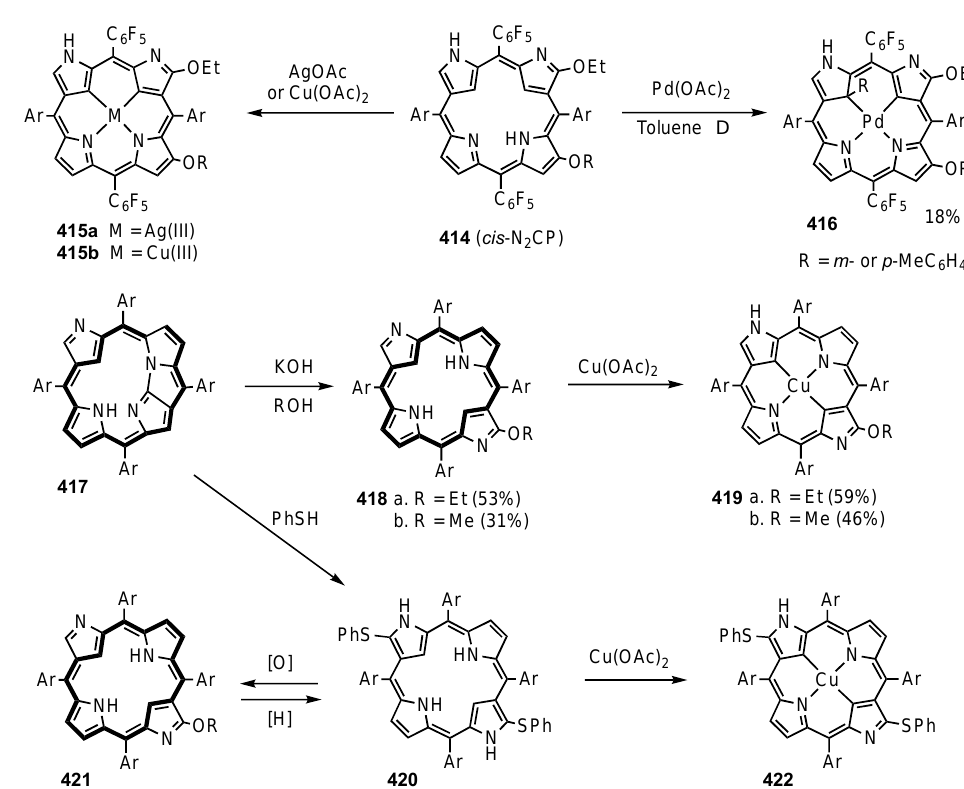
Scheme 66. Metalation of doubly N-confused porphyrins.